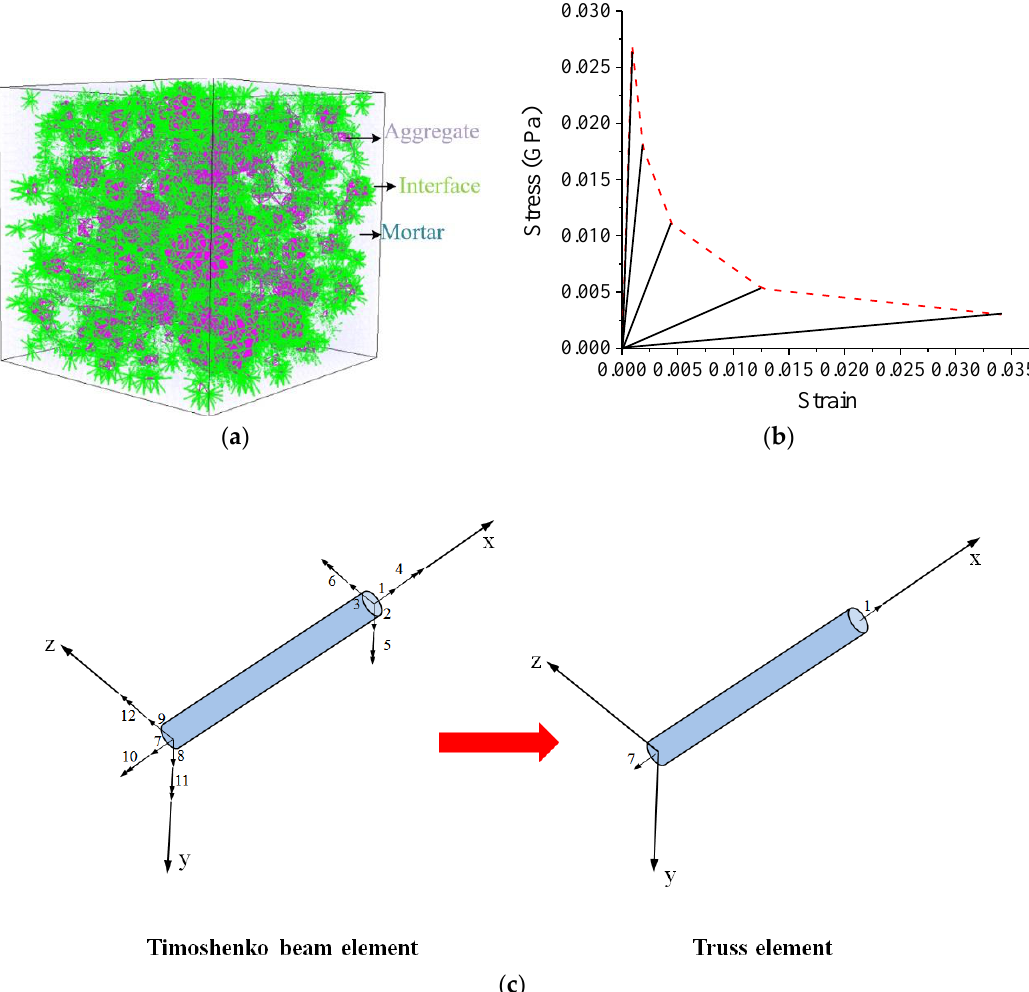
Figure 14. ( a ) Mesostructured model, ( b ) multi-linear constitutive relationship, ( c ) schematic view of the element degradation at the first step [53]. Reproduced from [53]. Copyright 2019, Elsevier.